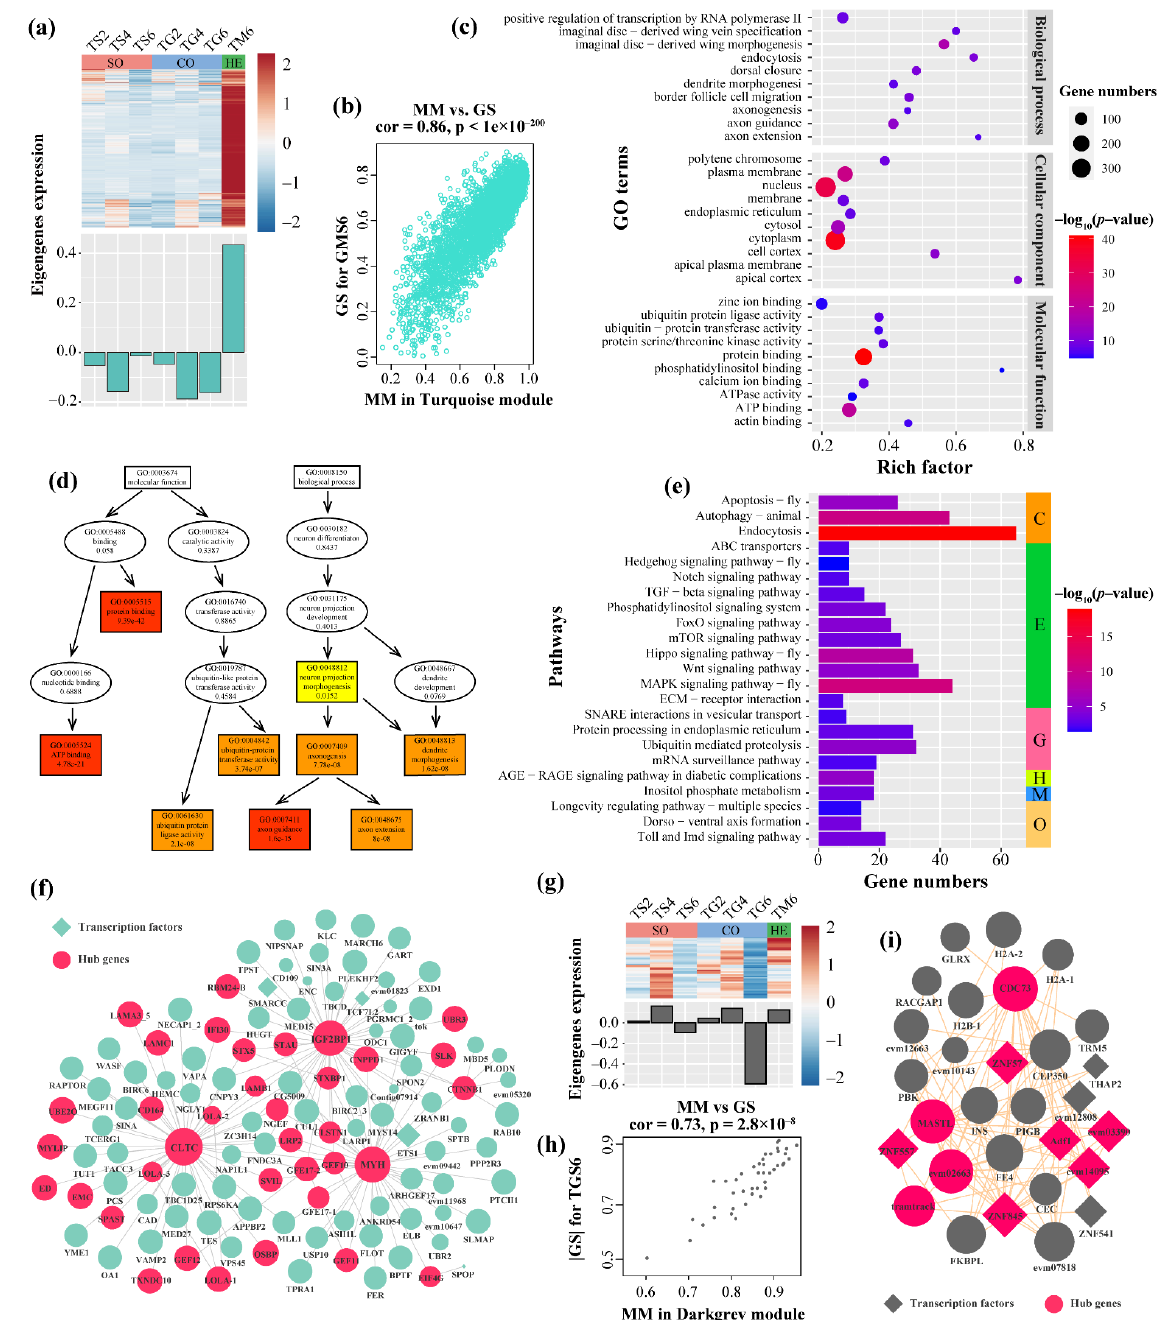
Figure 6. Turquoise and DarkGrey modules analyses. Gene expression pattern of Turquoise ( a ) and DarkGrey ( g ) modules. The heat map shows the expression patterns of each gene contained in the corresponding module; upregulated and downregulated genes are represented by red and blue, respectively. The histogram shows the variation in module eigengenes expressed in different samples. SO, solitary groups; CO, conspecific groups; HE, heterospecific groups. Scatter plots for correlations between module membership (MM) and gene significance (GS) in the Turquoise ( b ) and DarkGrey ( h ) modules. ( c ) GO and ( e ) KEGG enrichment for central genes (MM > 0.8 and GS > 0.6) from Turquoise module. ( d ) The thumbnail view of the directed acyclic graph (DAG) on biological processes and molecular function. The network for top 150 connectivity genes in the Turquoise ( f ) and DarkGrey ( i ) module. A node with a larger size indicates higher intramodular connectivity. The full list of the gene names of the nodes is shown in Table